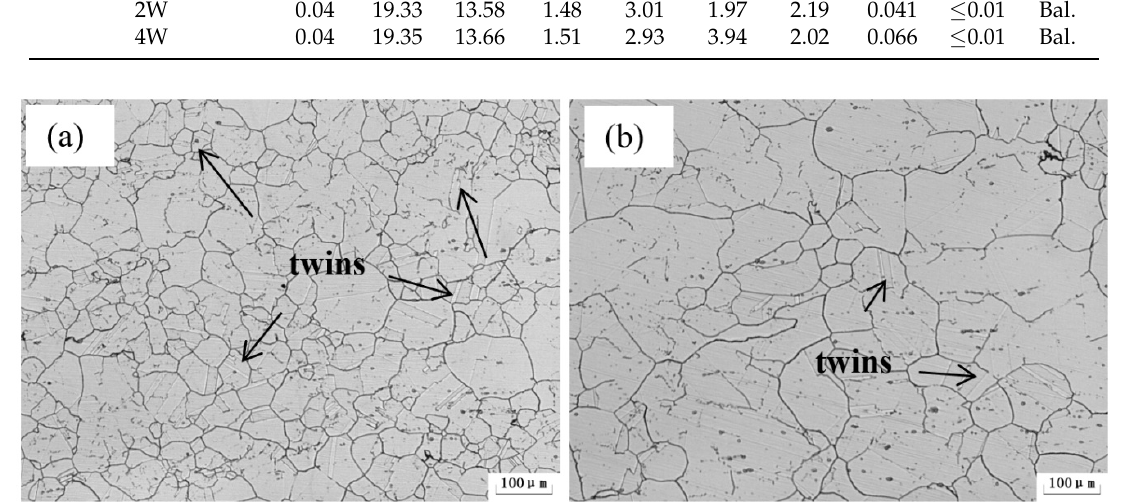
Figure 1. Micrographs before test ( a ) 2W ( b ) 4W.